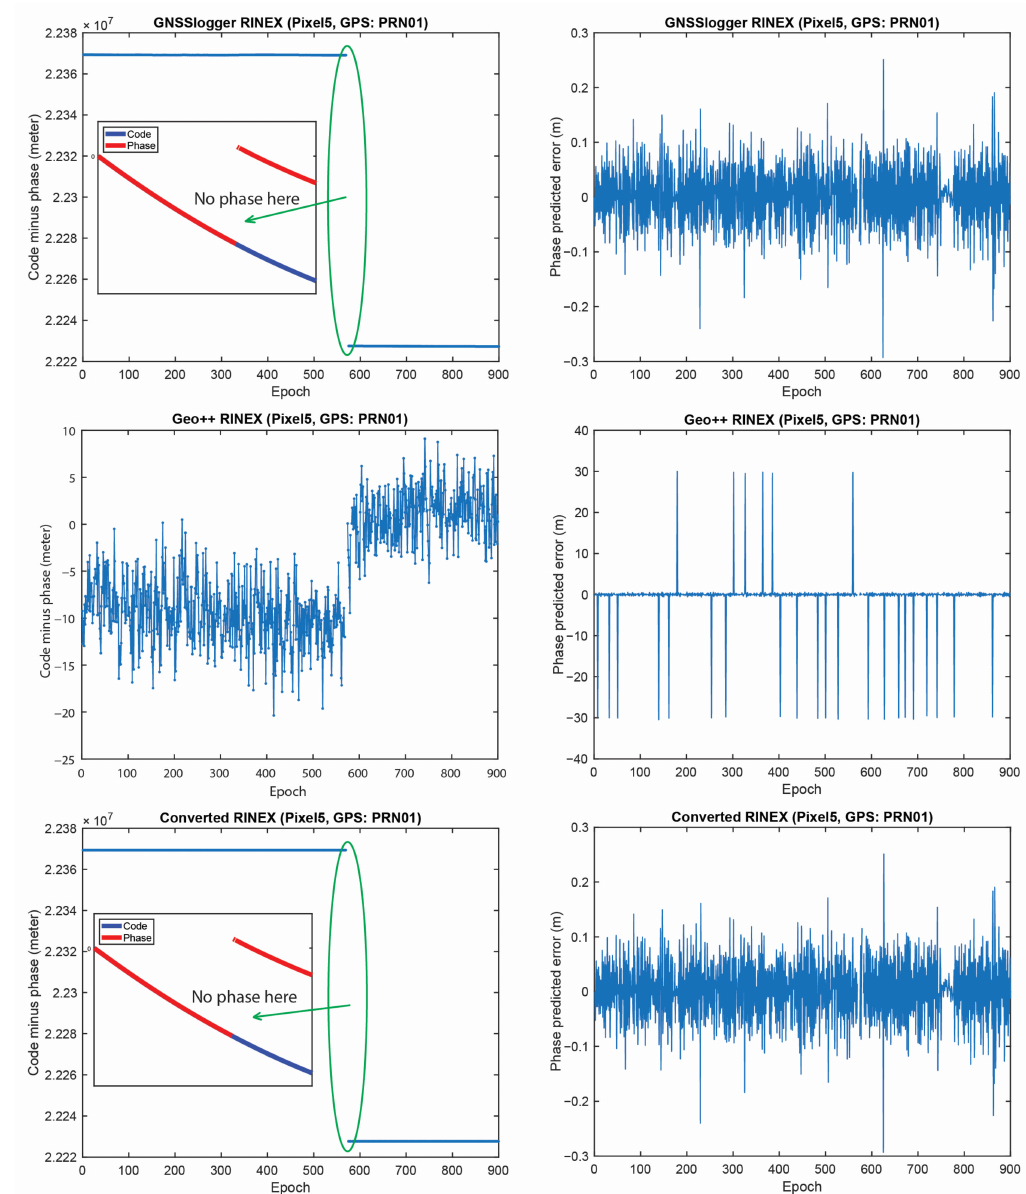
Figure 9. CMP and carrier-phase predicted error for GPS PRNs 01 (Google Pixel